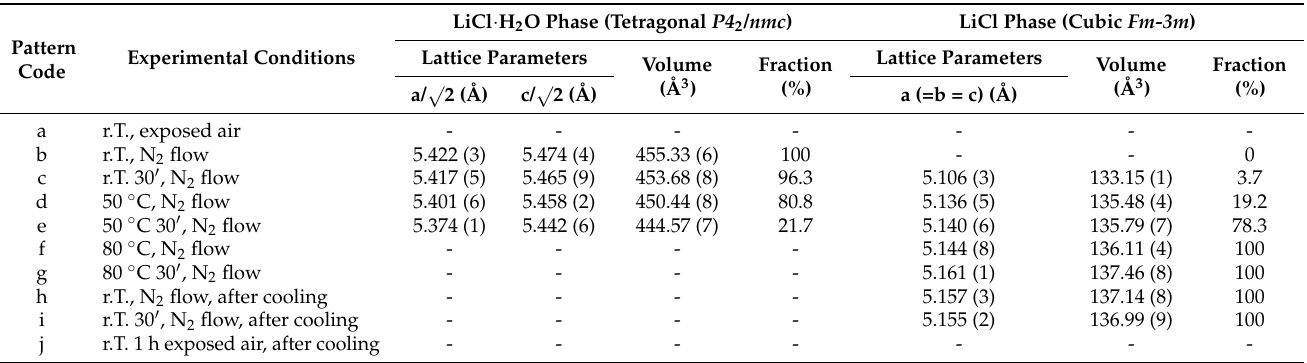
Table 1. In situ XRD pattern code, experimental conditions, refined lattice parameters, volume, and phase fraction.